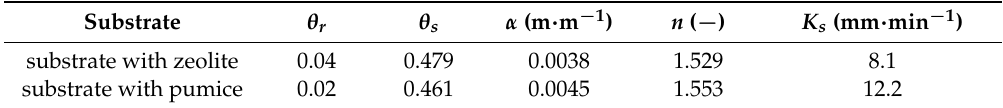
Table 2. Soil hydraulic parameters used in Hydrus